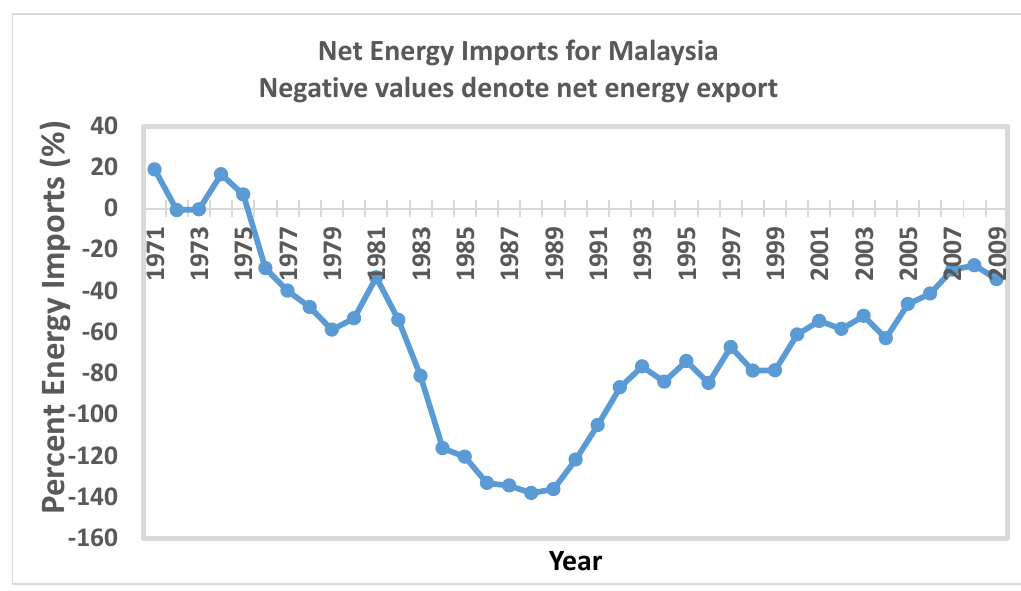
Figure 3. Net energy imports of Malaysia as a percentage of energy use. Negative percentage denotes that Malaysia is a net energy exporter. Data were obtained from [38] and plotted by the